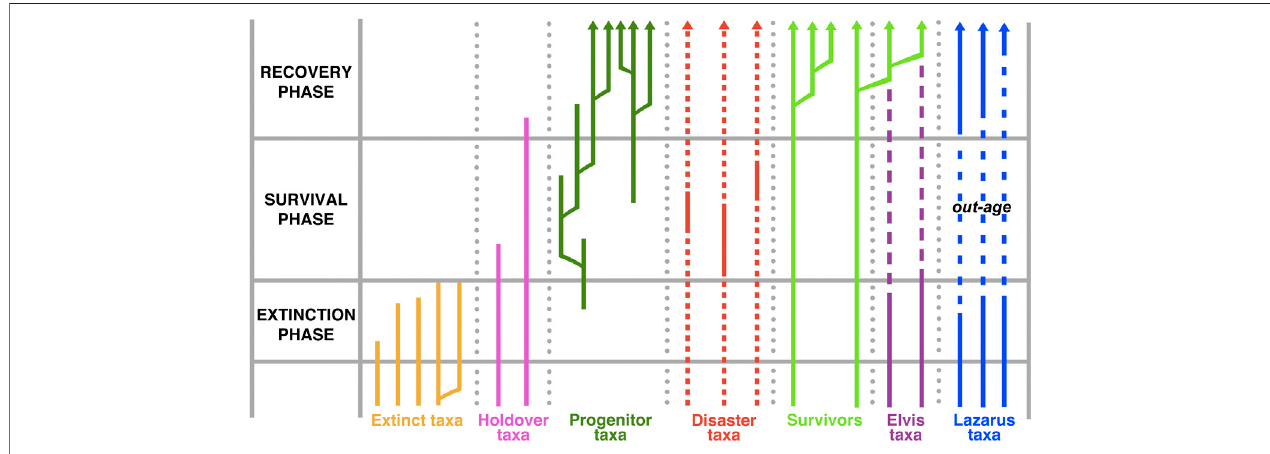
FIGURE 1 | Hallam and Wignall (1997) generalized model showing the range of responses of species to mass extinction.